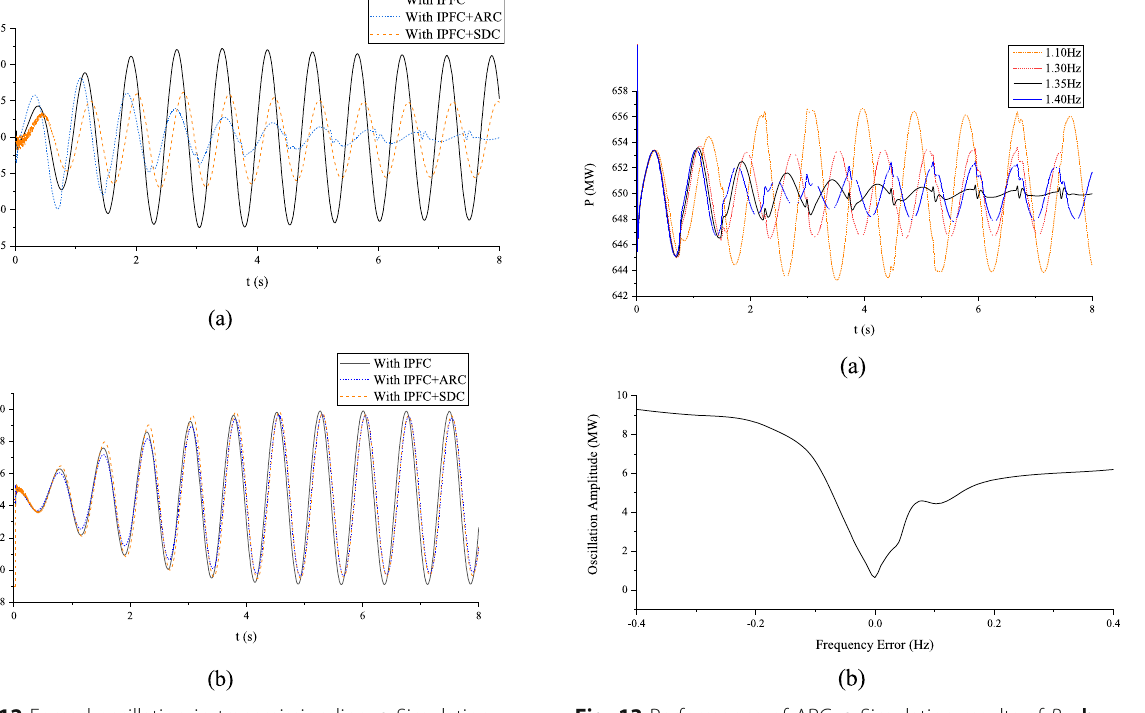
Fig. 13 Performance of ARC: a Simulation results of P ik ; b Oscillation amplitude of P ik under different frequency